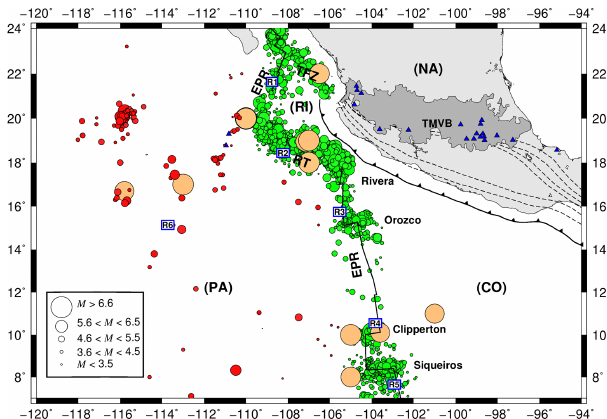
Figure 2. Seismicity in the oceanic environment off the Pacific coast of Mexico from 1899 to 2017. The size of the circles repre- sents magnitude. Brown circles are relevant historical earthquakes shown in Table 1 with M> 6 . 8. Red circles are intraplate oceanic events, and green circles are transform fault zone, and mid-ocean ridges earthquakes. Epicenters were compiled from the Mexican National Service (SSN) and the International Seismological Centre (ISC)